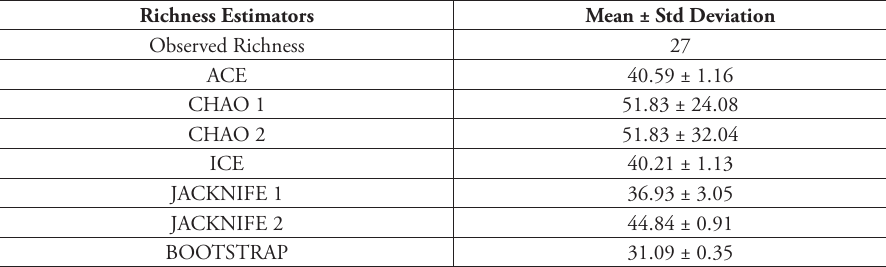
Table 2. Richness estimators of snake assemblages for the south coast of Paraíba. Richness